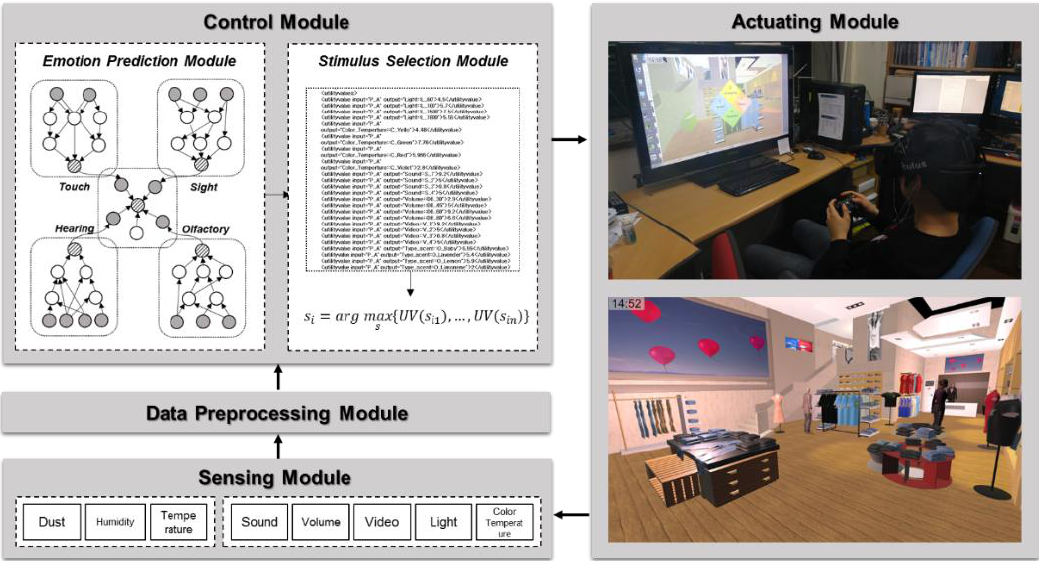
Figure 5. The proposed system.